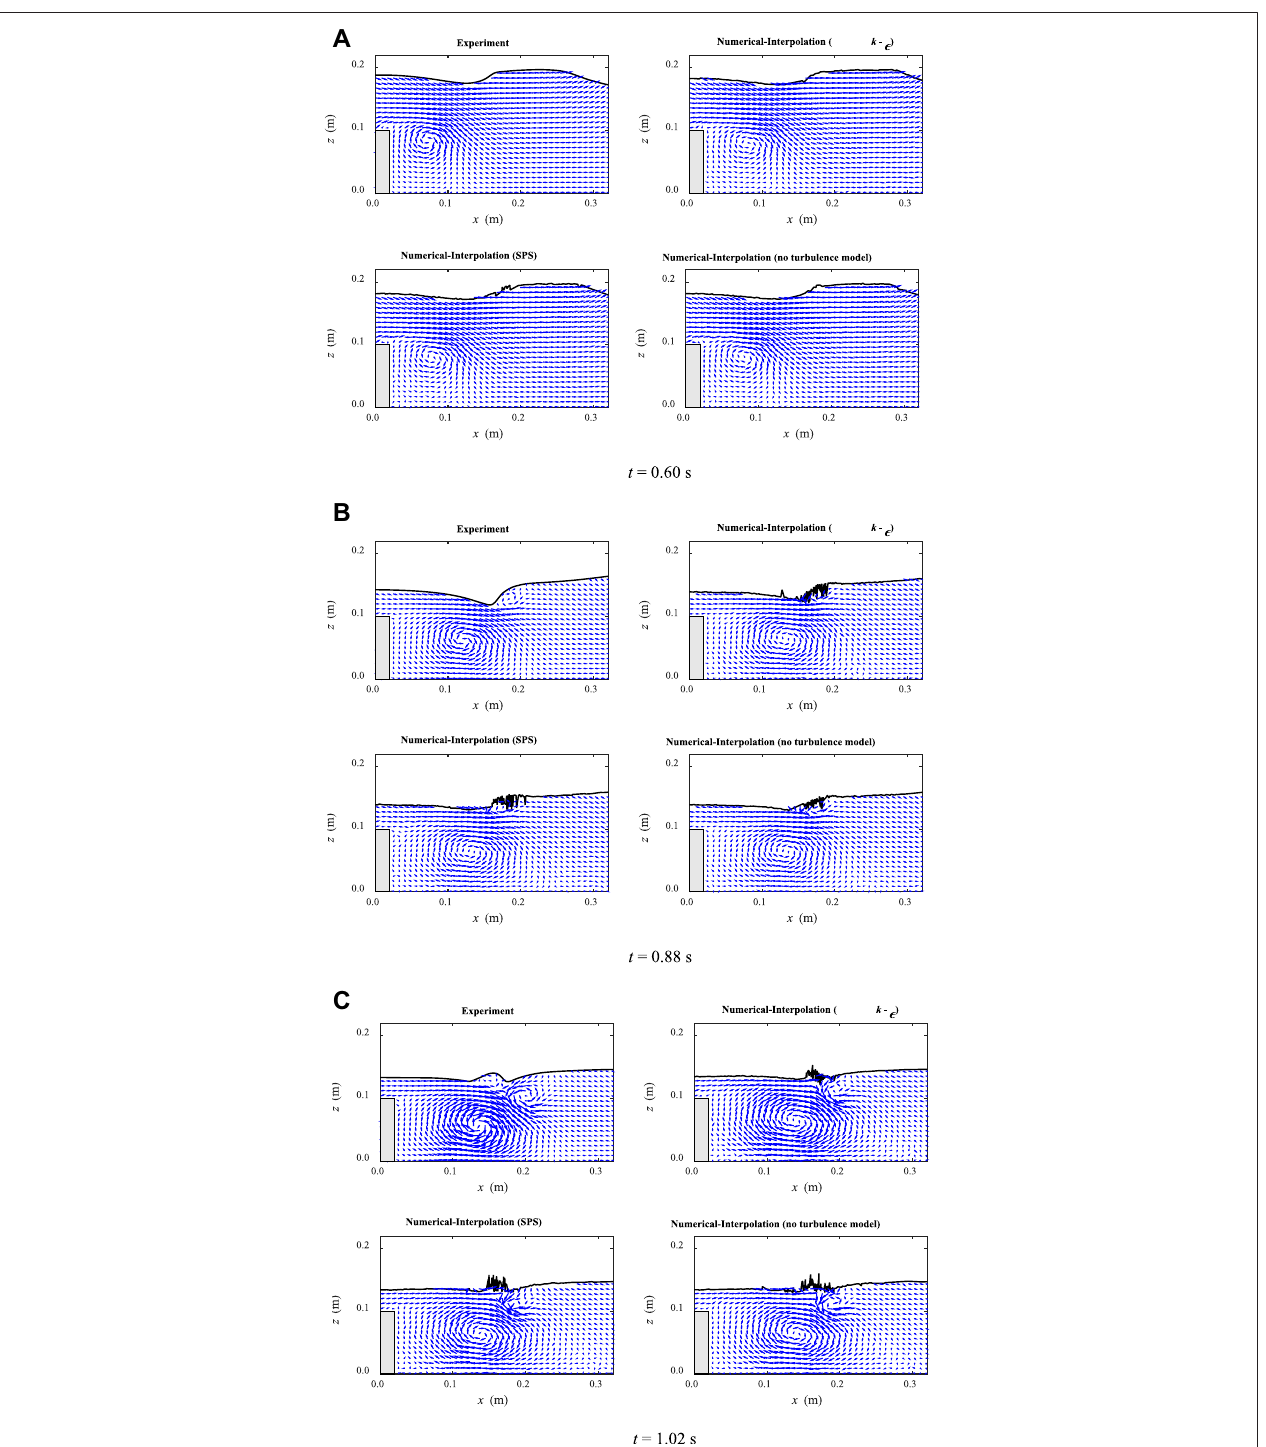
FIGURE 4 | Comparisons between experimental data and numerical results for the velocity fi elds at three times t (cid:2) (A) 0.60 s; (B) 0.88 s; and (C) 1.02 s.